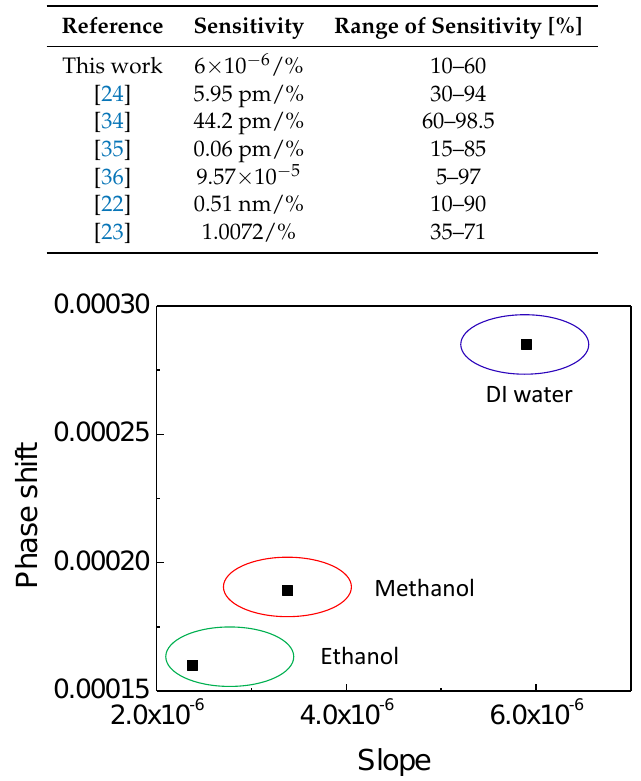
Table 2. Comparison of the polymer coated straight microtaper-based sensor reported in this work with other sensors recently reported, in sensitivity to relative humidity (RH) percent change and total range of sensitivity.